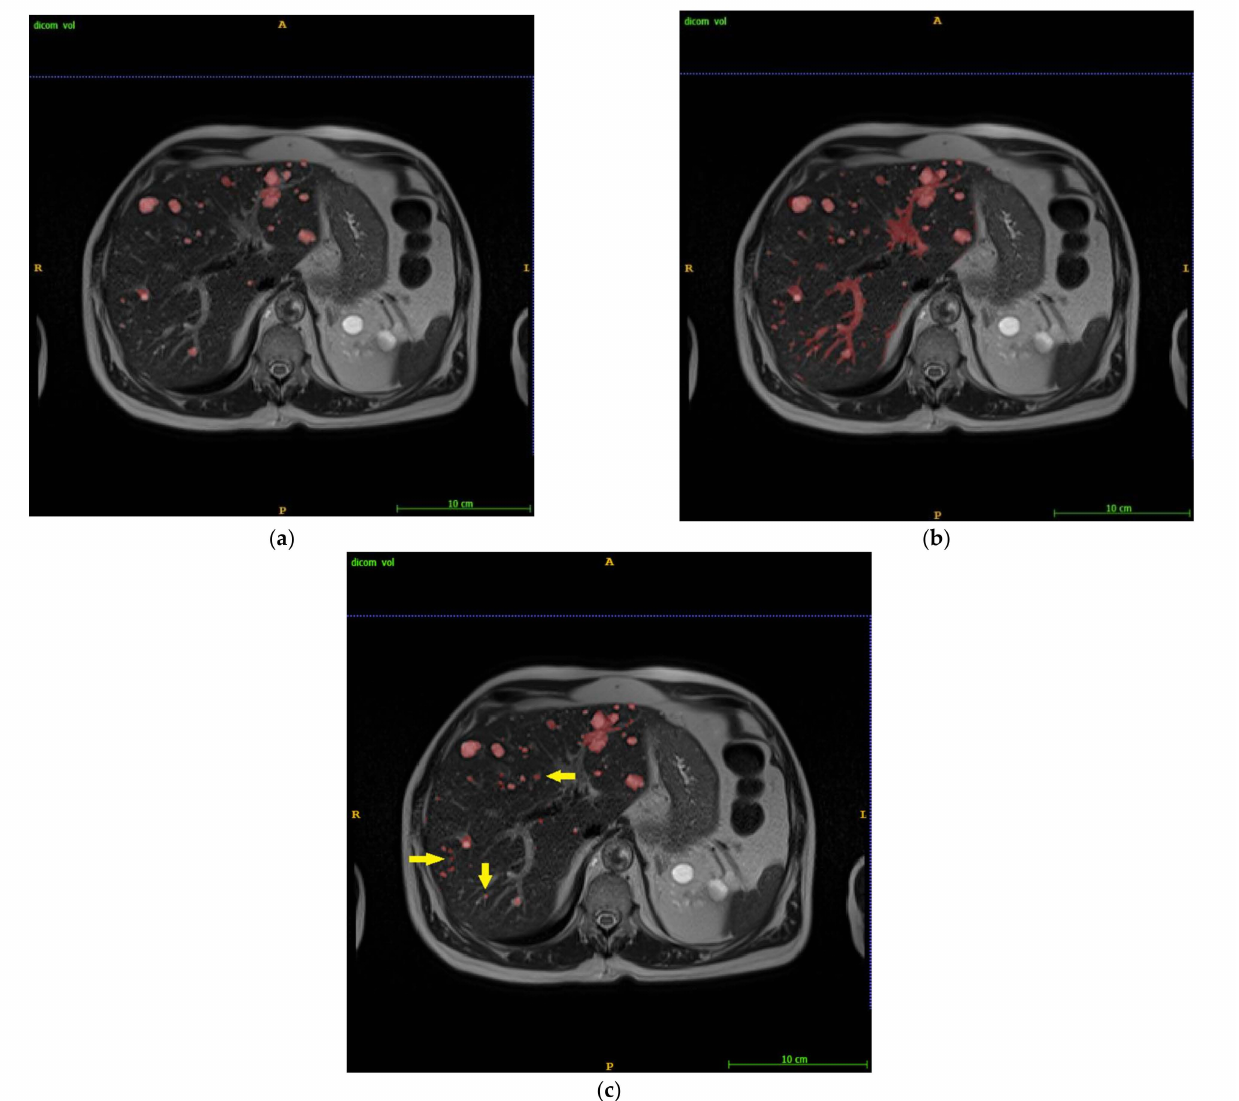
Figure 1. Liver cyst segmentation by ( a ) manual as ground truth (GT), ( b ) automated level set (LS), and ( c ) IRIS. LS included substantial vasculature ( b ), which was cleaned up rapidly using anti- SmartClick ( c ). Small cysts missed on manual GT were captured on IRIS (arrows in ( c )). Speed metrics comparing GT, LS, and IRIS are shown in Table 1. On average, the IRIS method took 202 s, which was 10.7 times faster than manual GT of 2159 s ( p = 8.92 × 10 − 6